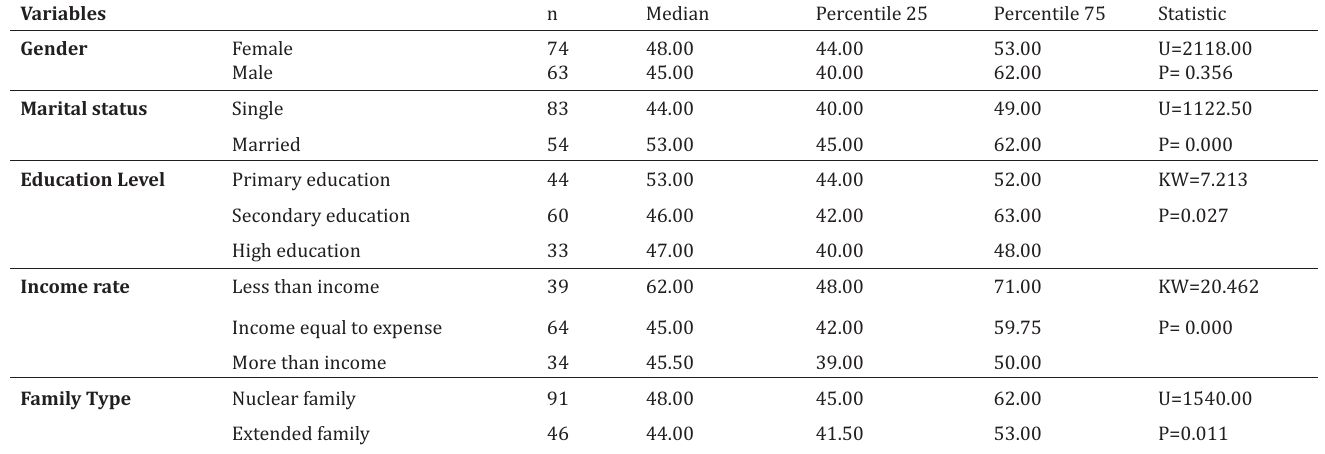
Comparison of the Demographic Characteristics of the Individuals and Zarit Care Burden Scale Variables